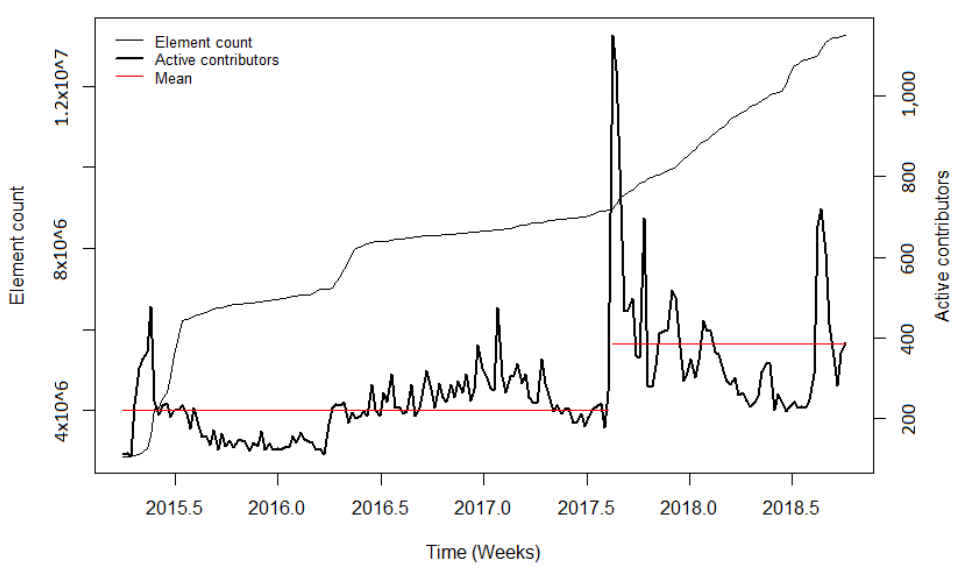
Figure A6. Contributor activity during the building import.